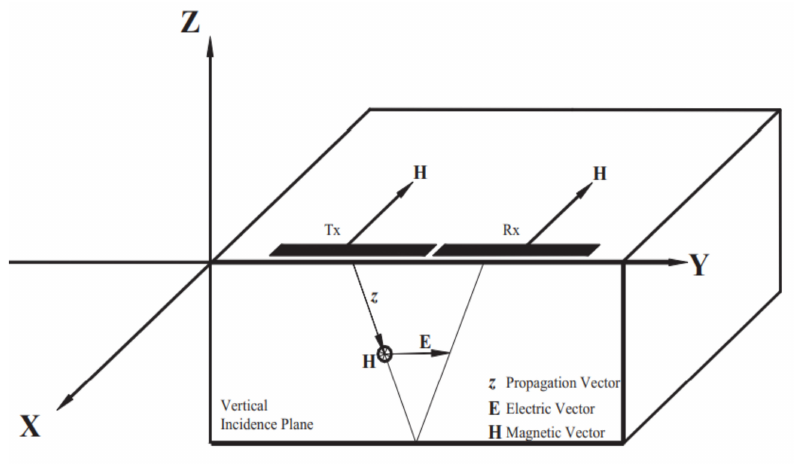
Figure 2. The orientation of transmitter (Tx) and receiver (Rx) in the TM polarization mode of GPR data acquisition